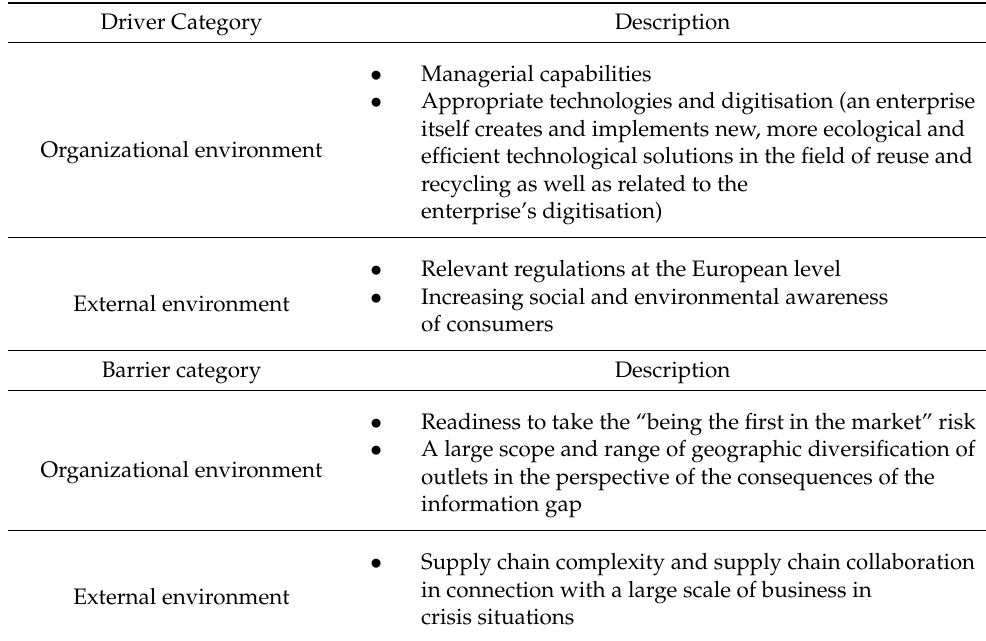
Table 1. Drivers and barriers to